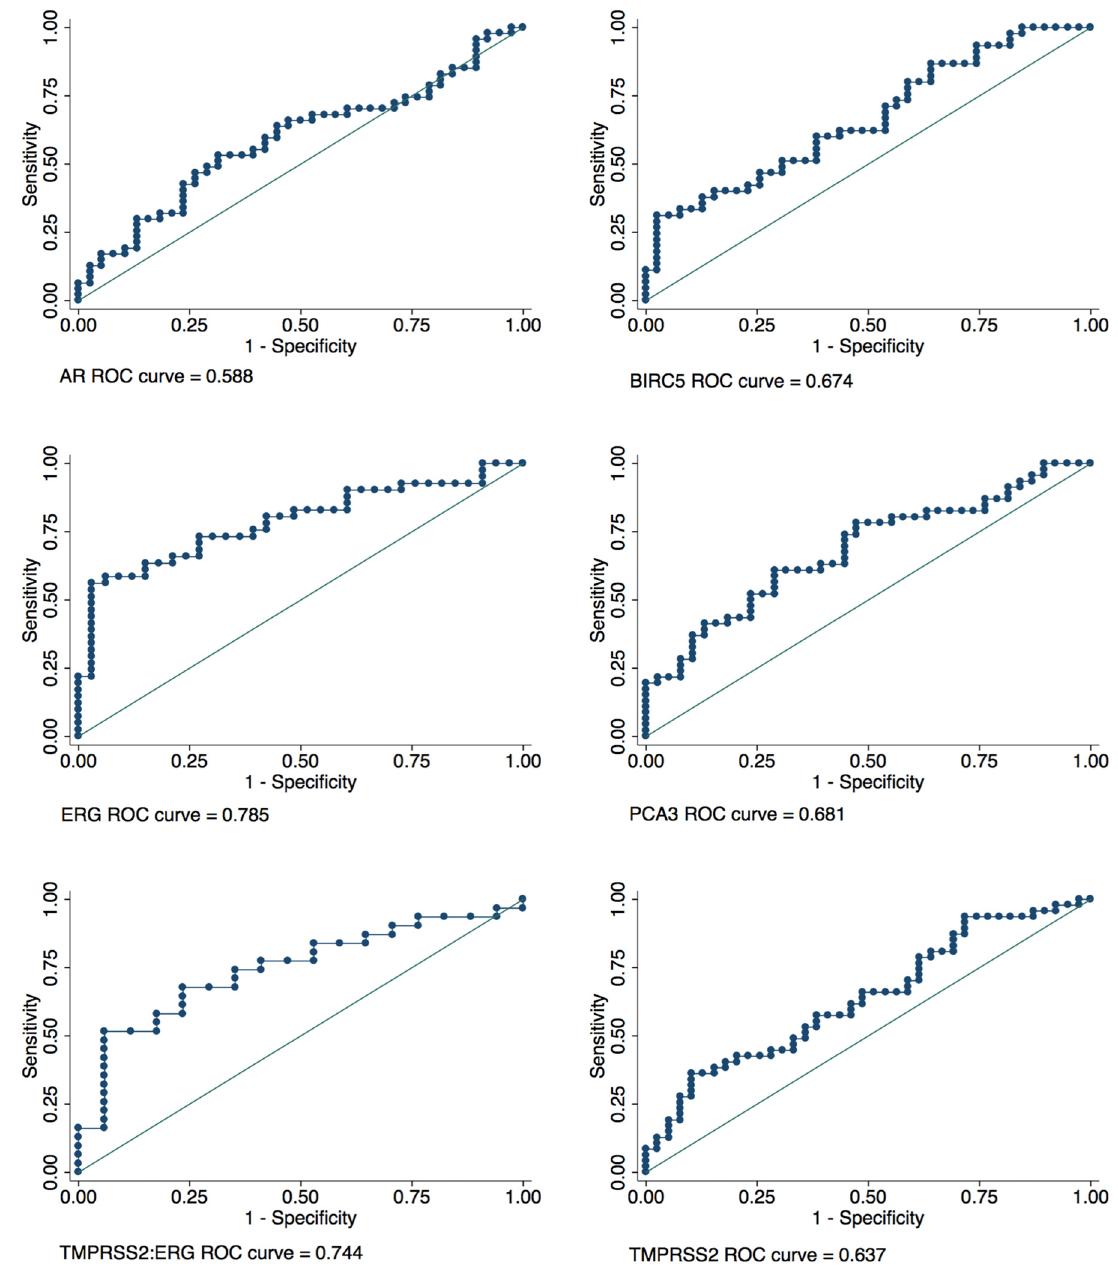
Fig 4. ROC Analysis of Prostate Related Genes. Individual ROC curves for AR, BIRC5, ERG, PCA3, TMPRSS2:ERG and TMPRSS2. T:E — TMPRSS2:ERG. AR (Bx Neg n = 38, Bx Pos n = 47), BIRC5 (Bx Neg n = 39, Bx Pos n = 45), ERG (Bx Neg n = 33, Bx Pos n = 41), PCA3 (Bx Neg n = 38, Bx Pos n = 46), TMPRSS2:ERG (Bx Neg n = 17, Bx Pos n = 31) and TMPRSS2 (Bx Neg n = 39, Bx Pos n =